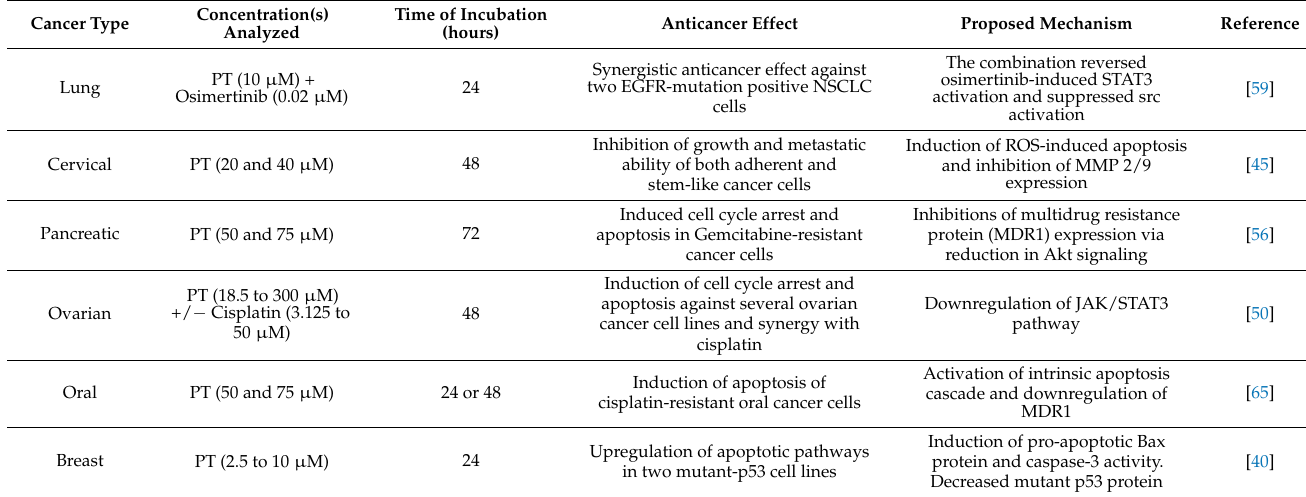
Figure 1. Potential molecular mechanisms involved in pterostilbene-induced cancer cell death. The multiple molecular interactions and signaling mechanisms are based on or deduced from data obtained in metastatic melanoma cells under in vivo conditions. Pterostilbene (PT) is encircled, and its interactions (inhibitions or activations are indicated by a T line or an arrow, respectively). Abbreviations: iNOS, inducible nitric oxide synthase; nitric oxide, NO; guanylate cyclase, GNC; CAMP responsive element binding protein, CREB; signal transducer and activator of transcription 3, STAT3; B-cell lymphoma 2, Bcl2; B-cell lymphoma-extra large, BclxL; tumor protein p53, p53; Bcl2-assciated X protein, Bax; adrenocorticotropic hormone, ACTH; glucocorticoid, GC; glucocorticoid receptor, GR; nuclear factor erythroid 2-related factor 2, Nrf2; Kelch ‐ like ECH ‐ associated protein 1, Keap1; protein kinase C PKC; mitogen ‐ activated protein kinase, MAPK; phosphoinositide 3 kinase/protein kinase B/mechanistic target of rapamycin, PI3/AKT/mTOR; endothelial nitric oxide synthase, eNOS; reactive oxygen species, ROS; neutral sphingomyelinase, NSMase; mitochondrial permeability transition, MPT; nuclear factor kappa-light-chain-enhancer of activated B cells, NF-kB; nuclear factor of kappa light polypeptide gene enhancer in B-cells inhibitor, IkB; cyclooxygenase 2, COX2; TNF receptor-associated factor 2, TRAF2; inhibitors of apoptosis proteins, IAP. Table 1. PT and cancer cells under in vitro conditions: effects and proposed mechanisms. NSCLC: non-small cell lung